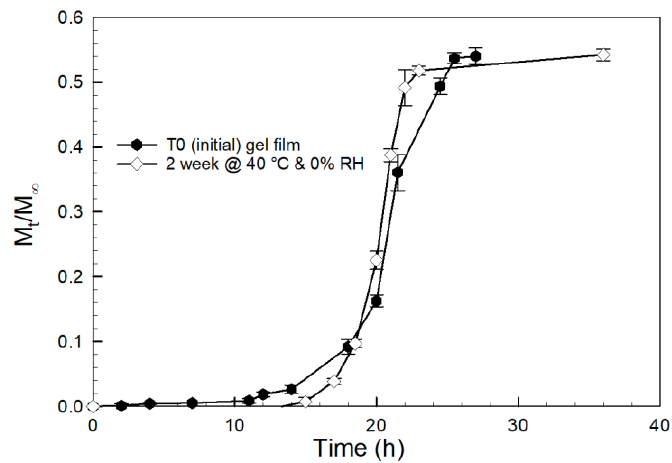
Figure 10. Curcumin release profiles in PBS for 90:10 CMA:PEG400DA PCBAE hydrogel films as-